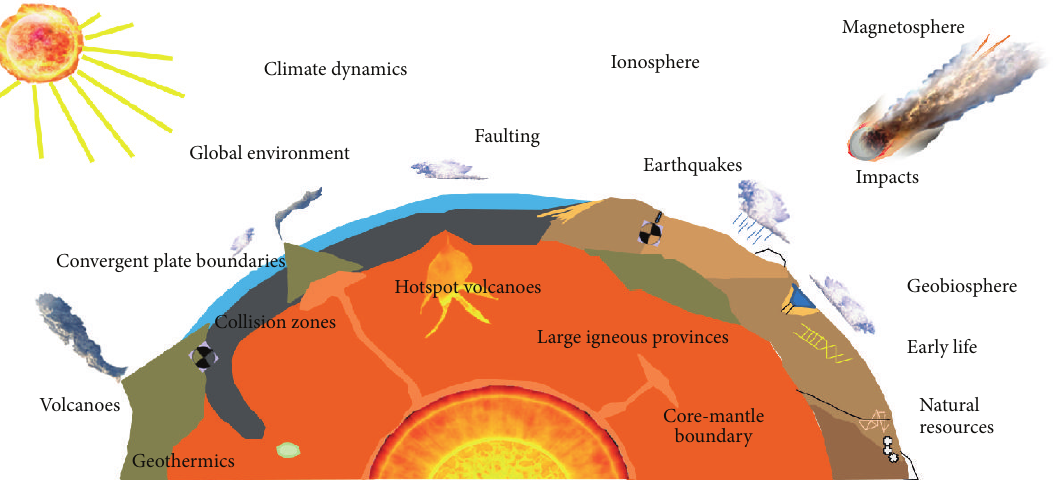
Figure 1: Earth system components connecting the Earth’s deep interior, core, mantle, lithosphere, atmosphere, oceans, magnetosphere, and ionosphere with external processes like asteroid impacts, cosmic radiation, and solar winds (credits: International Scientific Continental Drilling Program (ICDP) website: